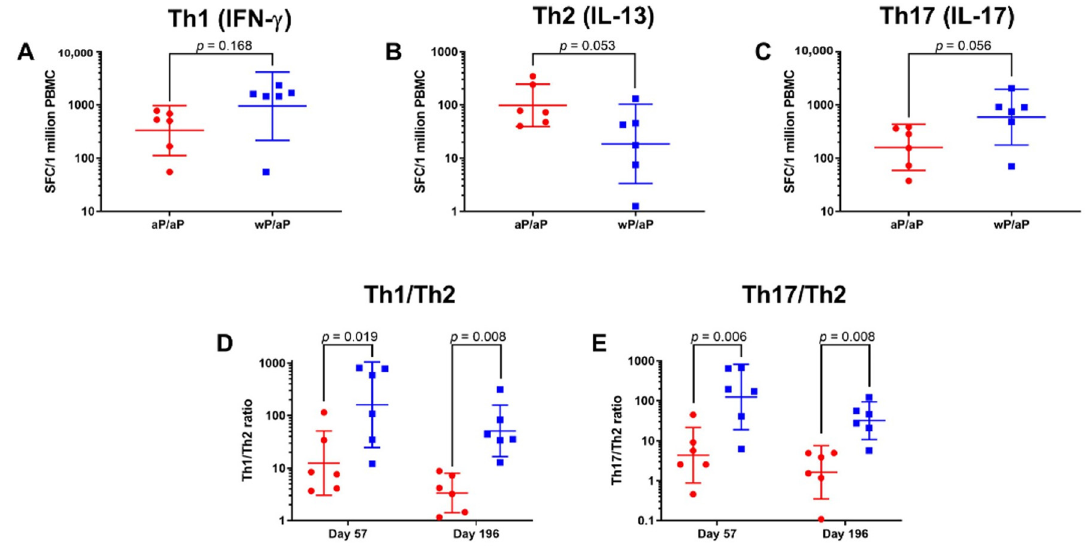
Figure 3. Assessment of T Cell Responses on Day 57 and Day 196 indicates durability of immune skewing after aP vaccine boosting. The data shown in the IFN- γ ( A ), IL-13 ( B ) and IL-17 ( C ) graphs are the individual values from day 196 with the geometric means and 95% CI noted with the corresponding lines. The Th1 / Th2 and Th17 / Th2 ratios were calculated based on the numbers of IFN- γ , IL-13, and IL-17 secreting cells after recall stimulation of PBMC with heat killed B. pertussis on days 57 and 196. Animals that were aP vaccine primed (day 57) or aP vaccine primed and aP vaccine boosted (day 196) are represented by red circles while animals that were wP vaccine primed (day 57) or wP vaccine primed and aP vaccine boosted (day 196) are represented by blue squares. The data shown in the graphs are the Th1 / Th2 ( D ) or Th17 / Th2 ( E ) ratios and the individual calculated values are shown with the geometric means and 95% CI noted with the corresponding